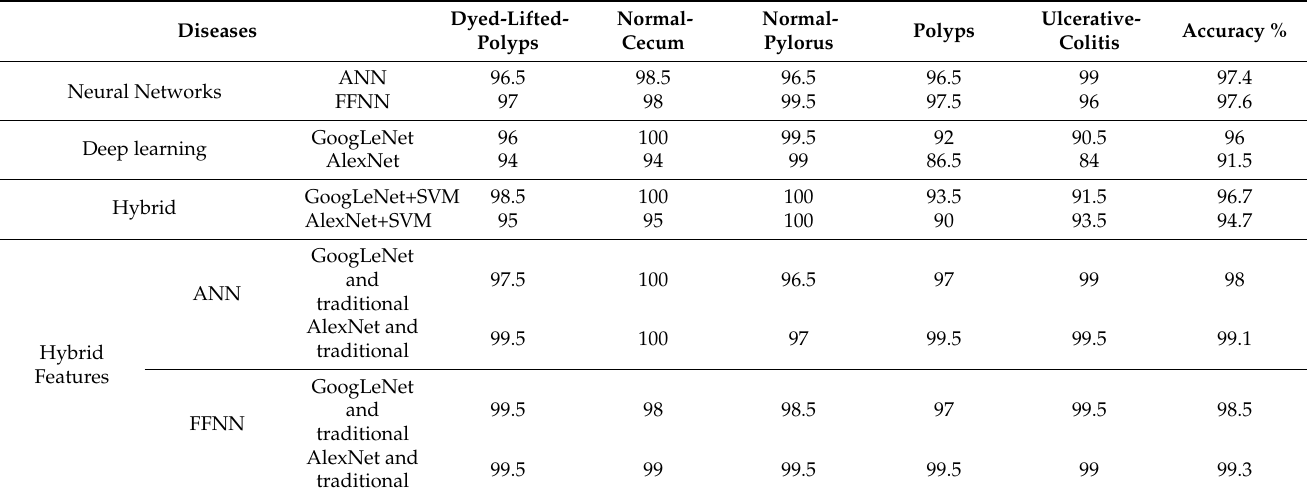
Table 8. The accuracy achieved by all the proposed systems for evaluating the gastroenterology dataset.